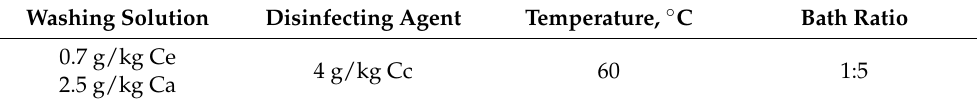
Table 3. Washing parameters [16,28].